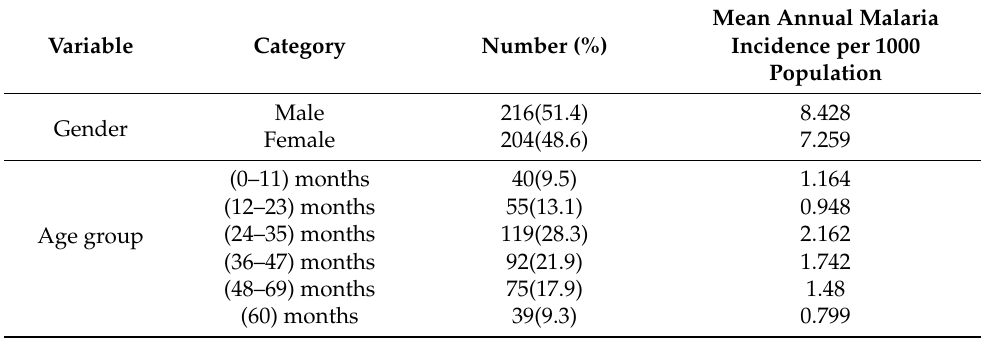
Table 2. Distribution of Malaria Cases and Incidence Rate by Gender and Age from 2015 to 2019 in Nsanje District.